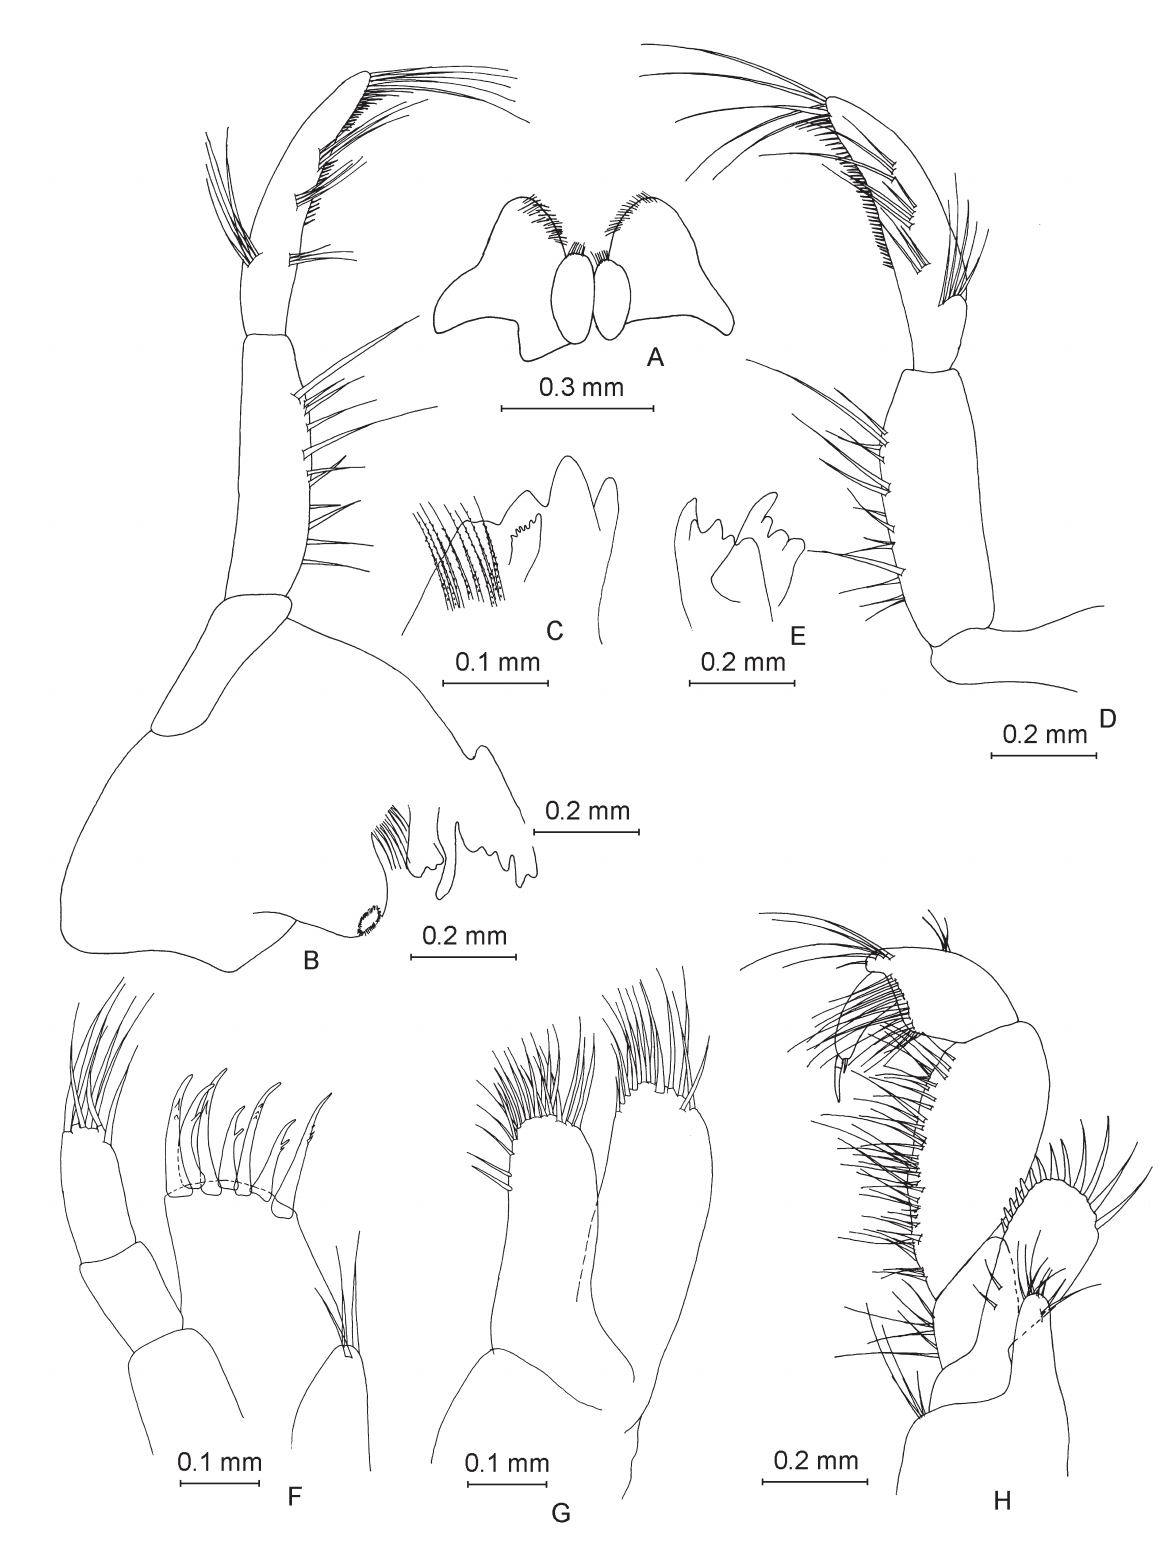
Fig. 4. ♂, mouthparts. A . Labium. B . Left mandible. C . Detail (the incisor process and lacinia mobilis) of left mandible. D . Right mandible. E . Detail (the incisor process and lacinia mobilis) of right mandible. F . Maxilla I. G . Maxilla II. H .